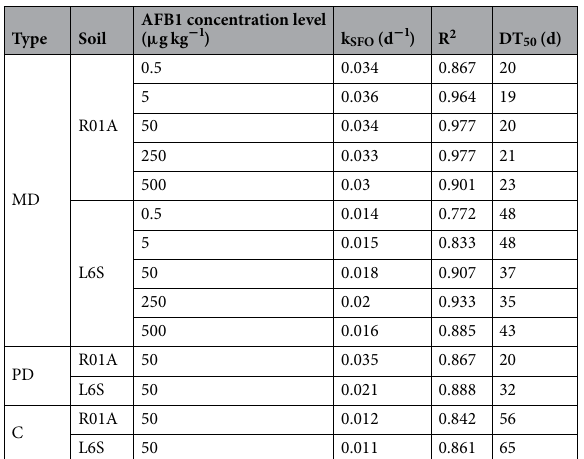
Table 2. Parameters of AFB1 dissipation kinetics for microbial degradation (MD), photodegradation (PD) and the sterile control in darkness (C): AFB1 SFO dissipation rates ( K SFO ) and 50% dissipation times ( DT 50 ) 2 and adjusted coefficient of determination ( R ).